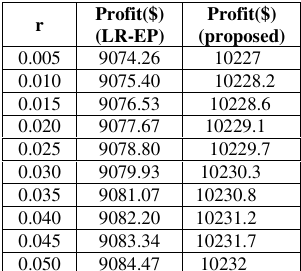
Table V and VI show examples of power and